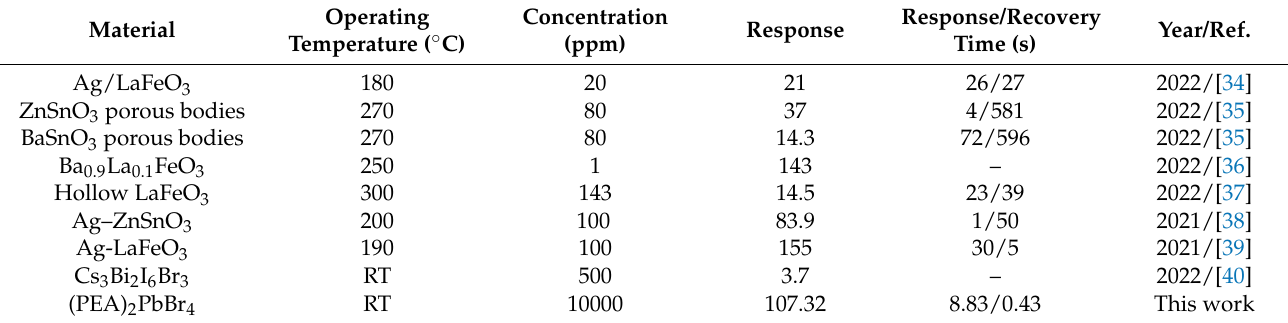
Table 1. Comparative summary of the ethanol sensing performance of the most recent various perovskite-based